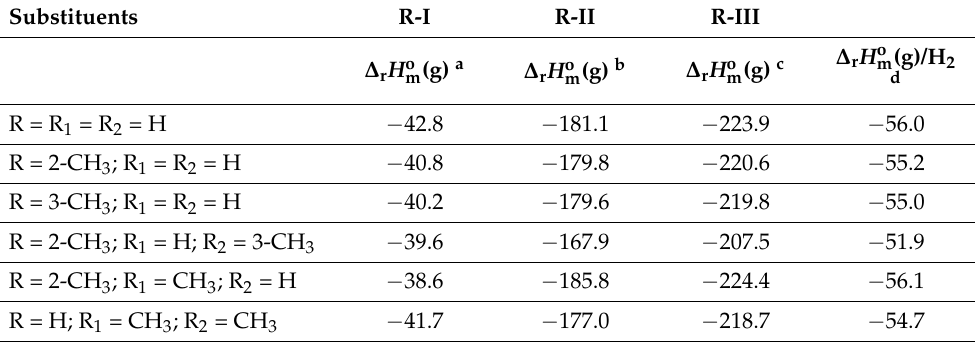
Table 10. Calculation of the gas-phase reaction enthalpies, ∆ r H o m (g), of the hydrogenation of indole